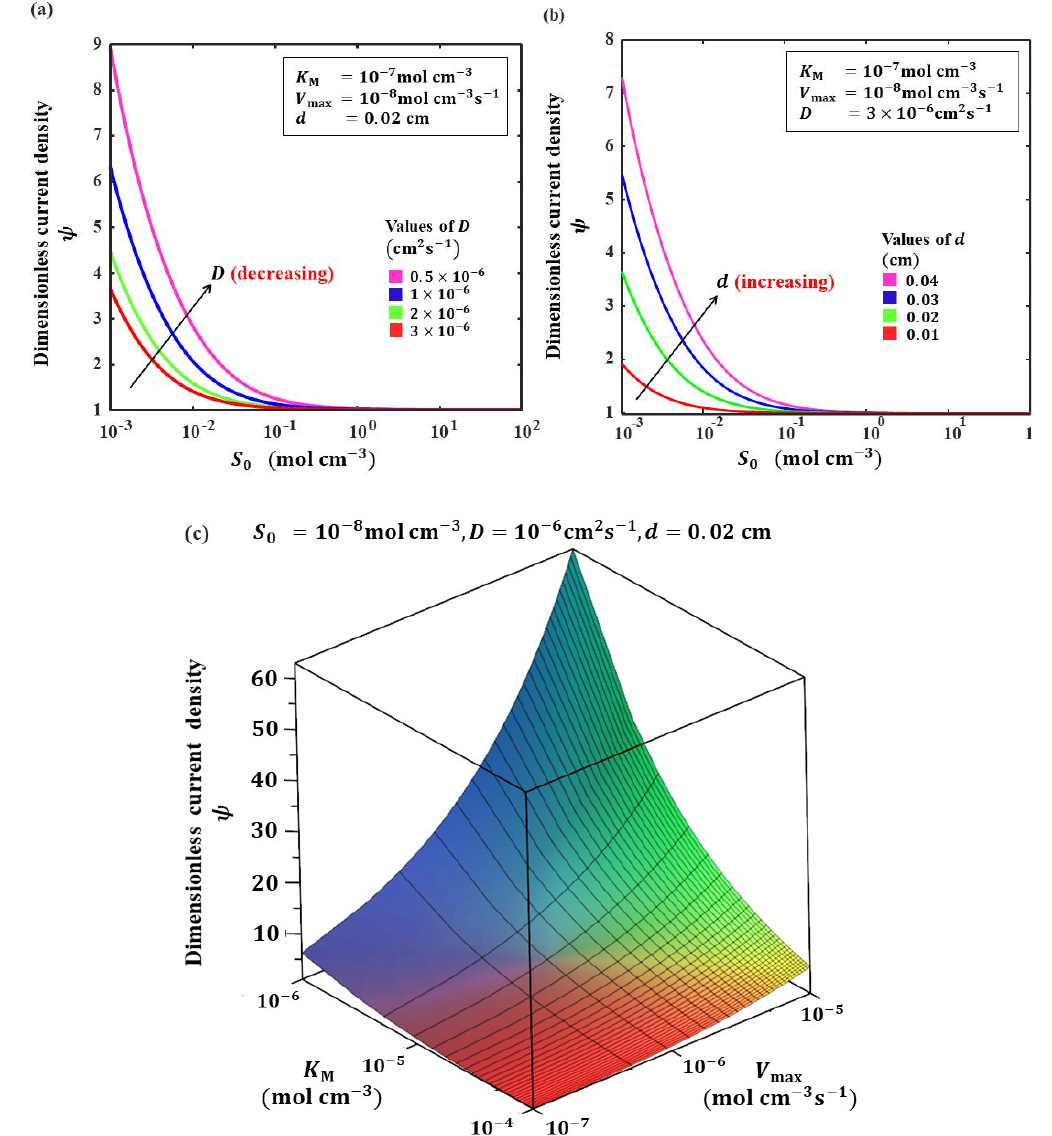
Figure 2. Dependence of current I in Equation (19) on substrate concentration for the varying values of ( a ) D and ( b ) d , and ( c ) the 3D representation of the variation of normalised current density with K M and V max .